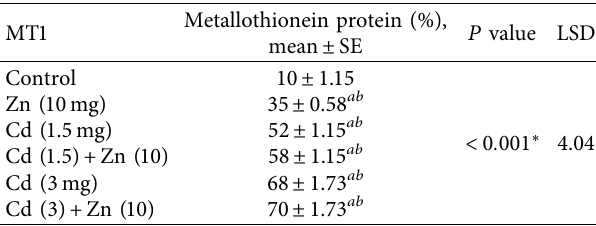
Table 2: Metallothionein protein percentage in mice hepatocytes exposed to cadmium and zinc chloride calculated using ImageJ